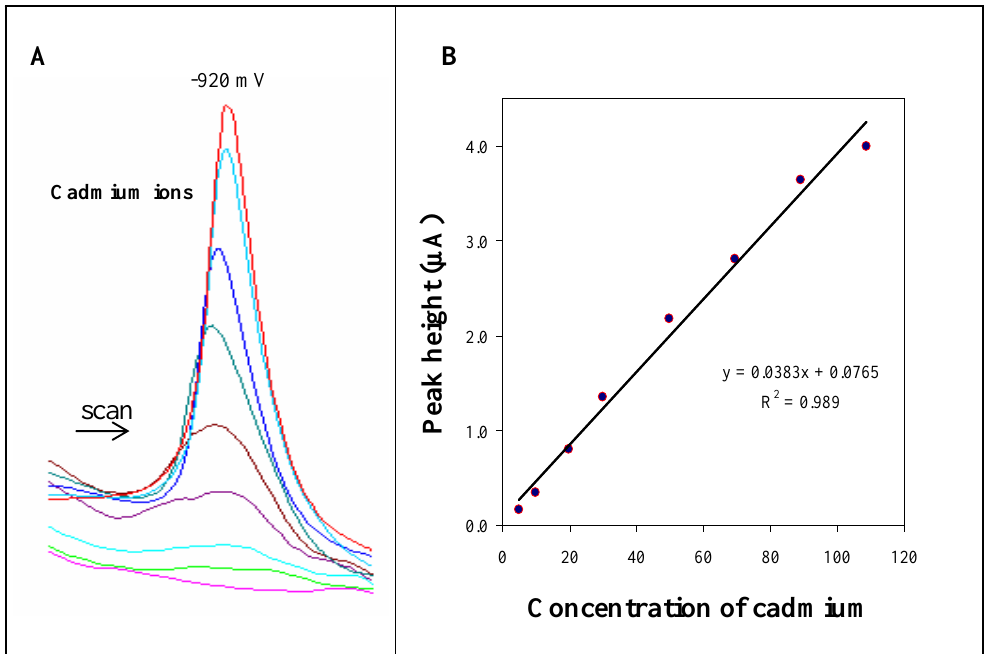
Figure 6. Differential pulse voltammograms of cadmium(II) ions (5 – 120 µM) measured by TFT sensor, gold working electrode carbon auxiliary and Ag/AgCl reference electrode. ( A ). Dependence of cadmium ions signals on its concentration ( B ). Background electrolyte 0.1 M KCl. Rotating Vessel response (50 rpm), x axis position 2 mm; y axis position 6 mm; z axis position 2.7 mm,